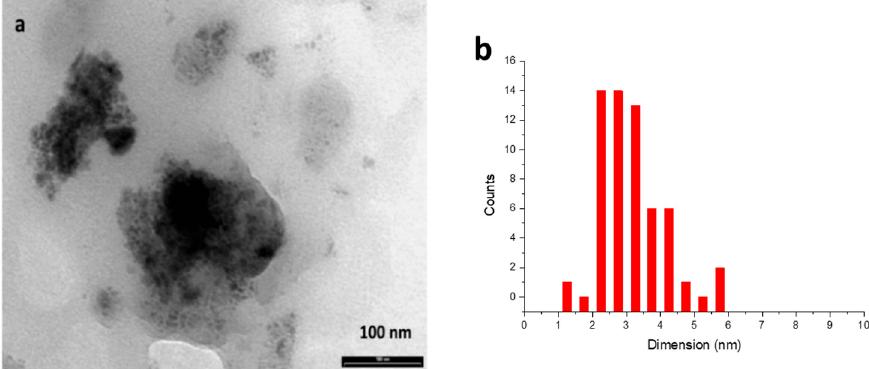
Figure 2. ( a ) TEM analysis of iridium nanoparticles recovered after reaction of entry 10, Table 2; ( b ) Size distribution of